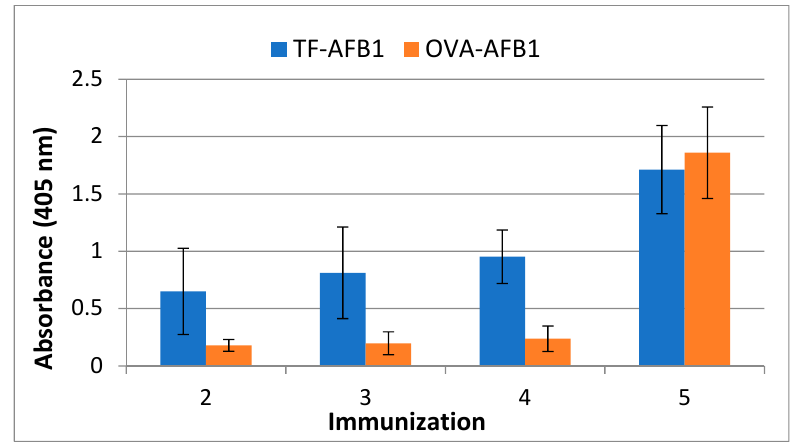
Figure 2. Comparison of AF specific immune response of mice immunized with OVA-AFB1-AFB1 or TF-AFB1. Mice sera were 2000 times diluted with PBS. The results are presented as a mean of antibody titers of 5 mice. Error bars represent standard deviations.